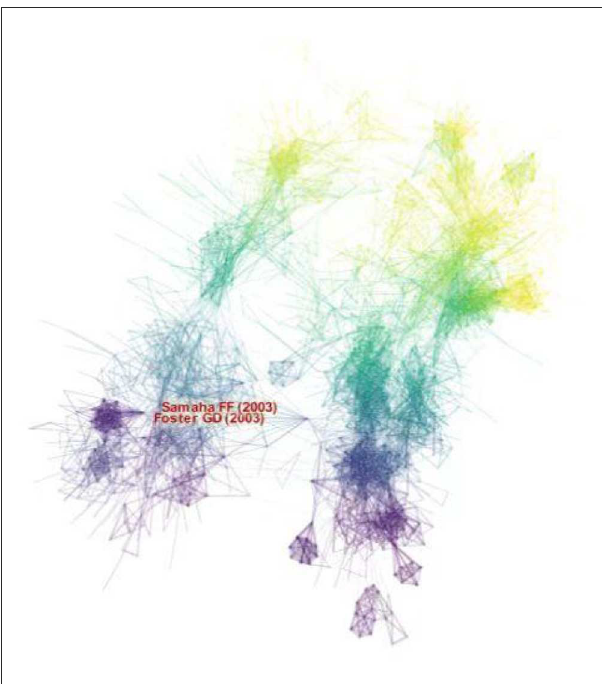
FIGURE7 The map of co-cited reference on LChD from 2002 to